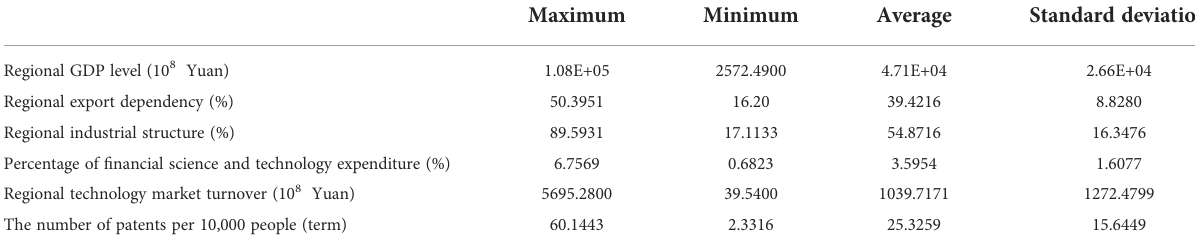
TABLE 2 Descriptive statistics of environmental in fl uencing factors.